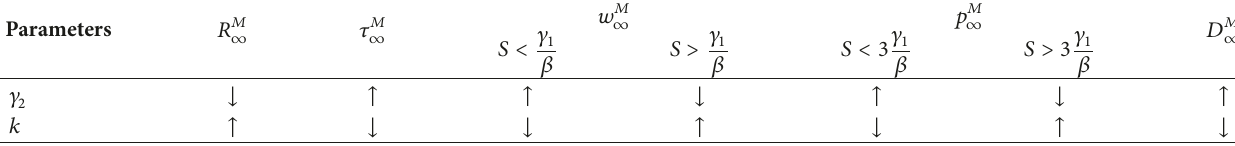
Table 2: Comparative static results for the myopic